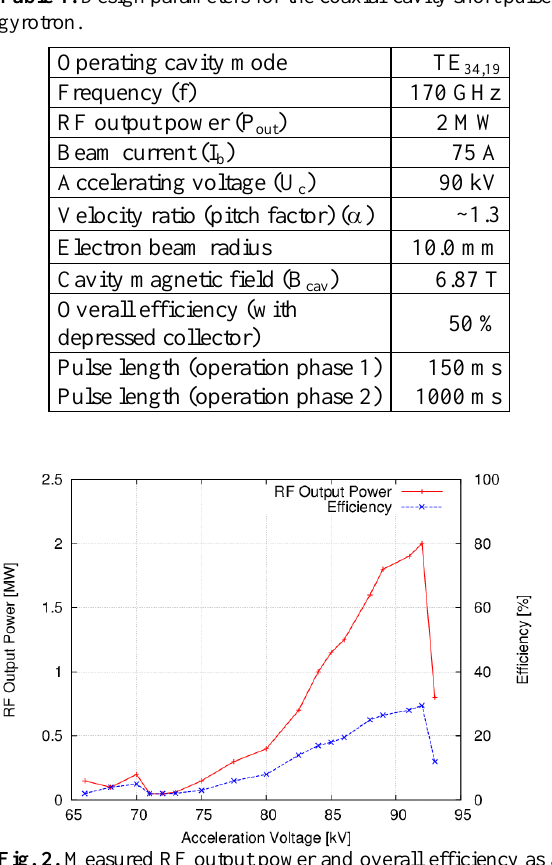
Fig. 1. Schematic sketch of the KIT 2 MW, 170 GHz short- pulse coaxial cavity gyrotron.